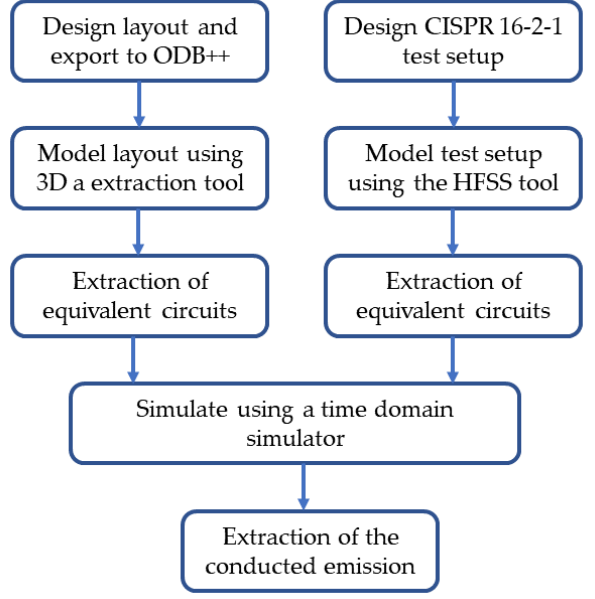
Figure 3. Workflow used by the authors to estimate conducted emission of SMPS according to CISPR CISPR 16-2-1.